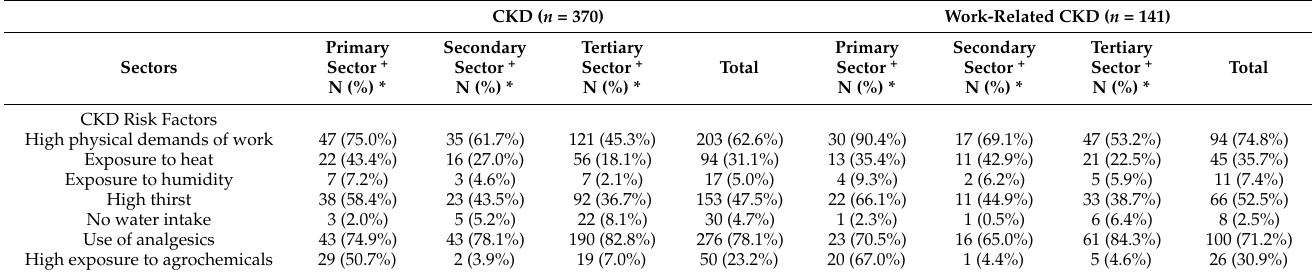
Table 2. CKD risk factors by industry sectors between CKD and work-related CKD for Central America.